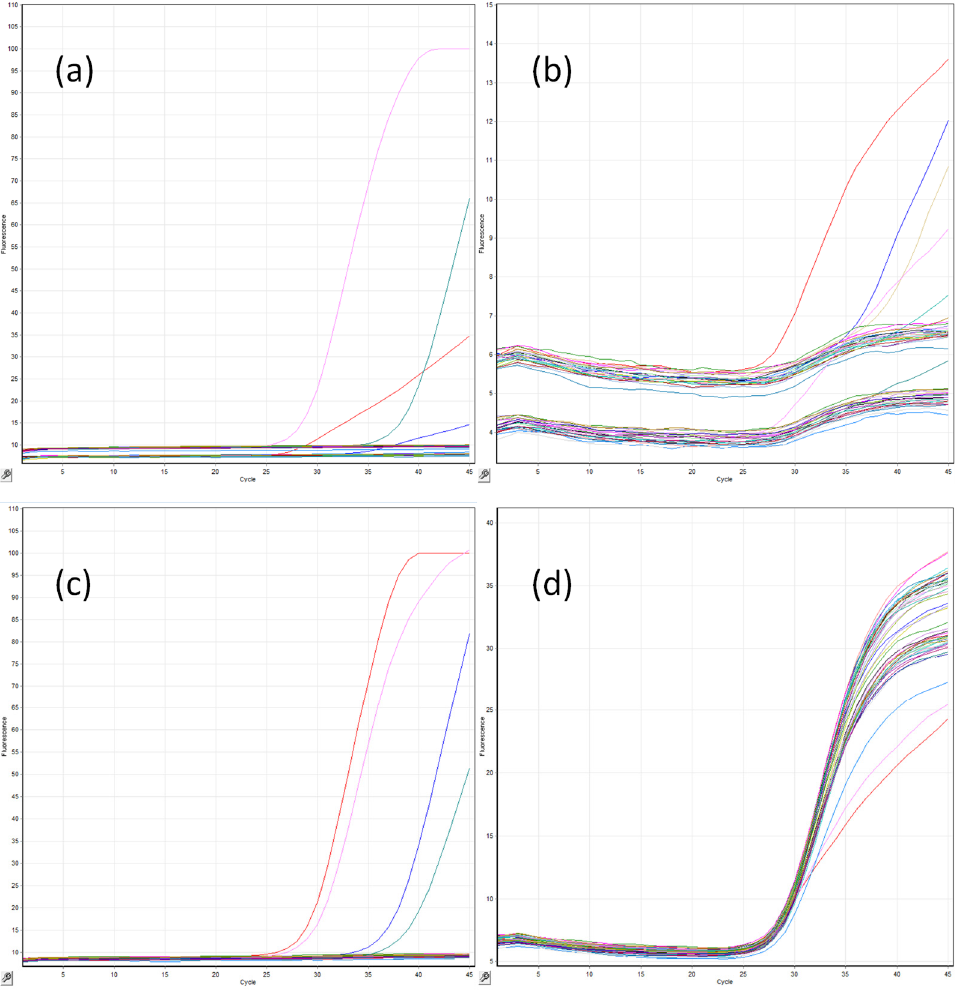
Figure 1. A typical OLM Cand ID and Cand ID plus multiplex real-time PCR tests on the Qiagen Rotorgene 6000 HRM instrument for the detection of ( a ) C. albicans / C. tropialis , ( b ) C. dubliniensis/C. parapsilosis , ( c ) C. glabrata/C. krusei , and ( d ) internal control, in which the horizontal axis reflects the number of cycles ( n = 45), and the vertical axis is the absolute fluorescence for each channel.